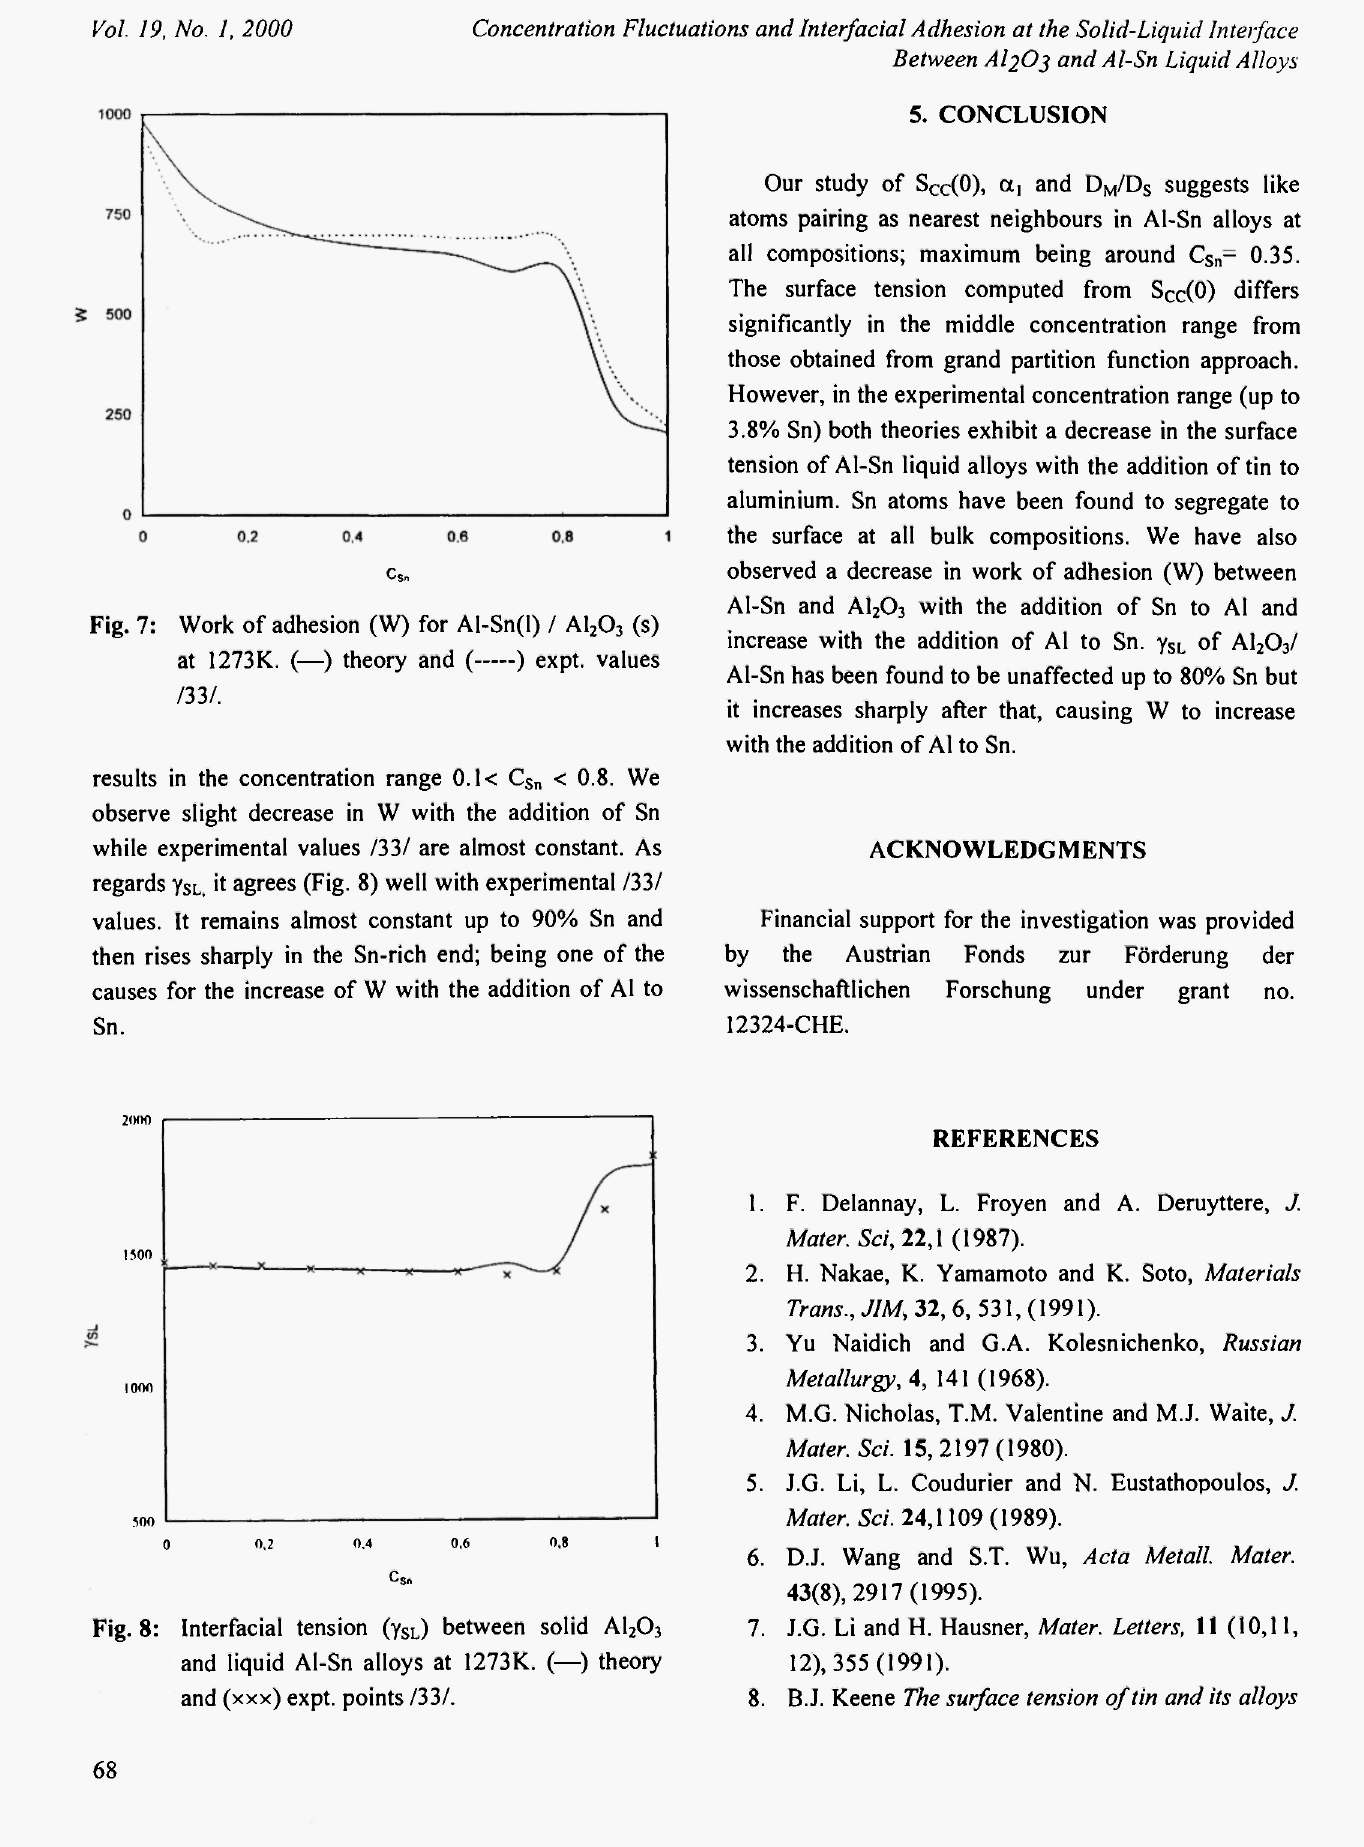
Fig. 8: Interfacial tension (y S l) between solid Al 2 0 3 and liquid Al-Sn alloys at 1273K. (—) theory and (xxx) expt. points